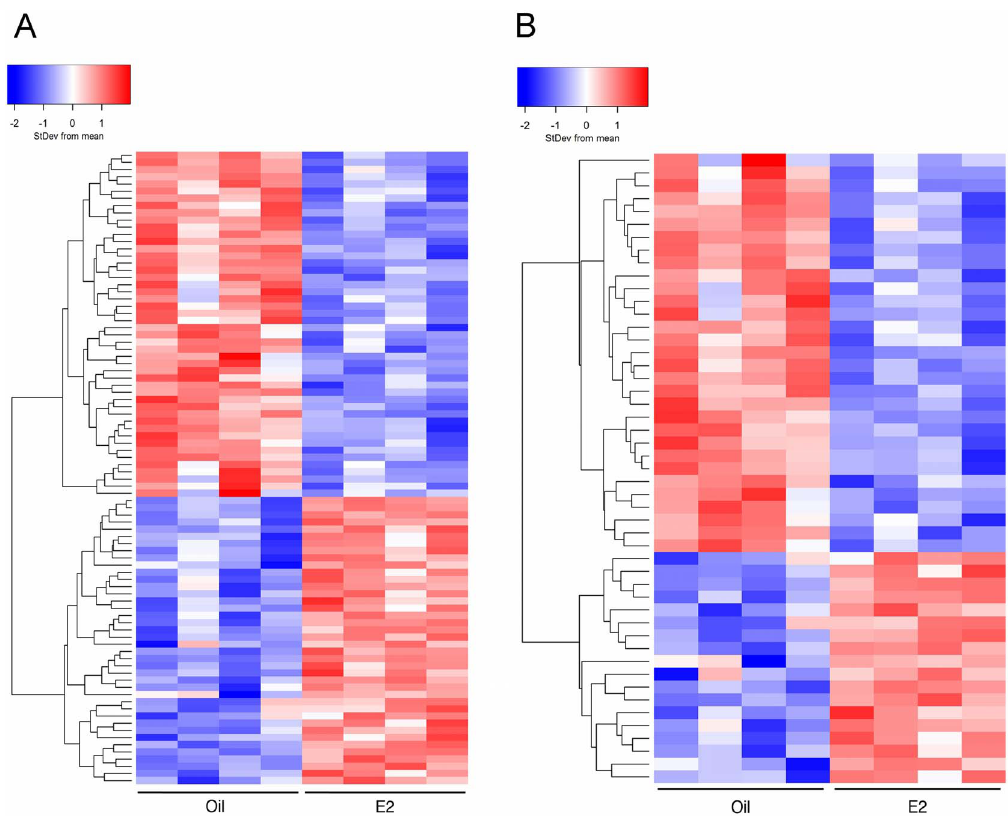
Figure 1. Heatmaps comparing cerebral cortices from oil- and E2-treated mice. Hierarchical clustering was used to visualize the transcript levels of (A) 88 genes that were significantly altered (FDR p , 0.05) by E2 treatment or (B) 49 genes that were altered 1.2 fold or more by E2 treatment (FDR p , 0.05). Each column represents cortical tissue from one mouse (8 mice total) and rows indicate genes. Colors symbolize increased (red) or decreased (blue) transcript levels.